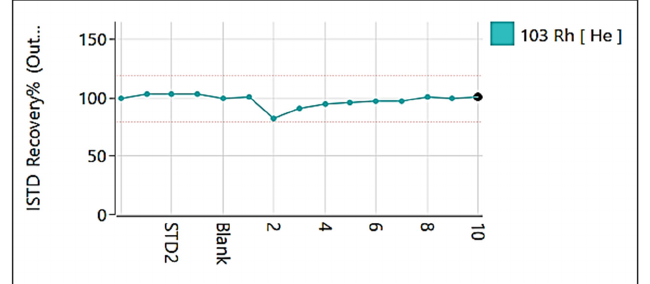
Figure 4. Plot of internal standard stability in an ICP-MS analysis of agri-food samples. Y-axis is referred to the percentage recovery of internal standard (Rh) solution.